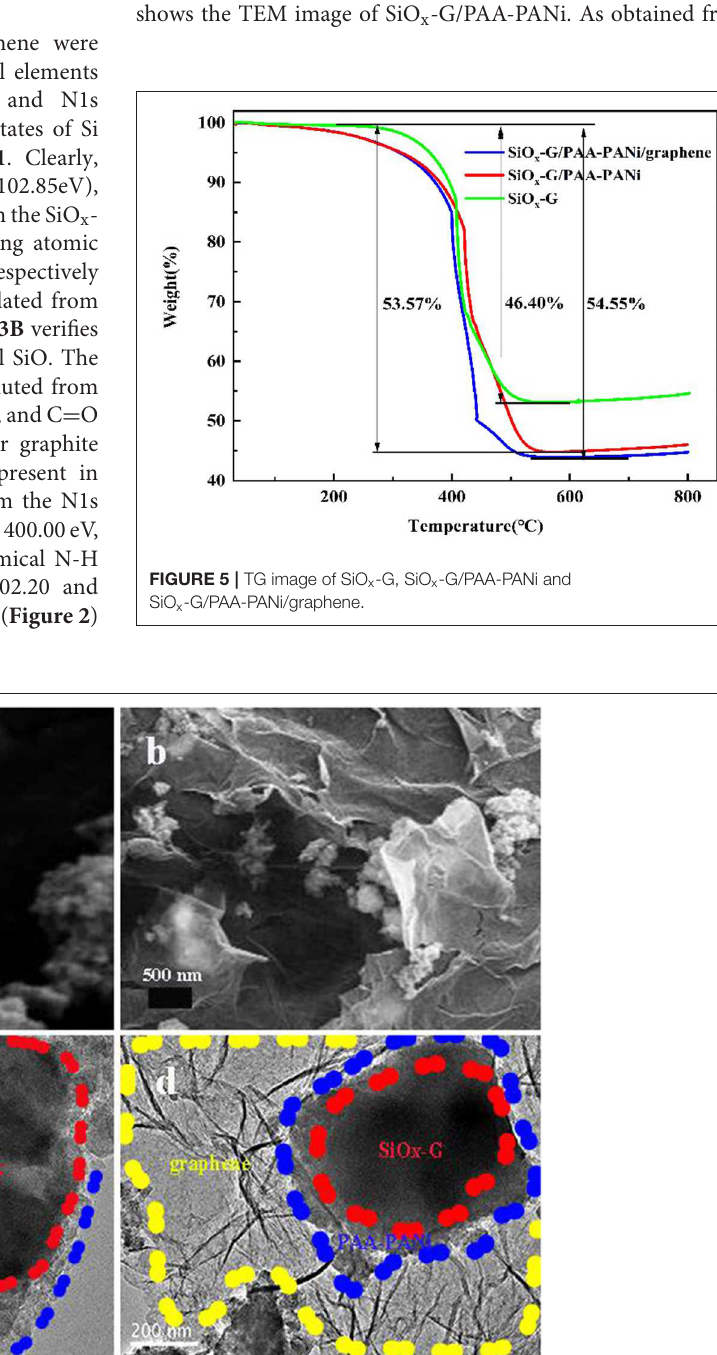
Frontiers in Chemistry |